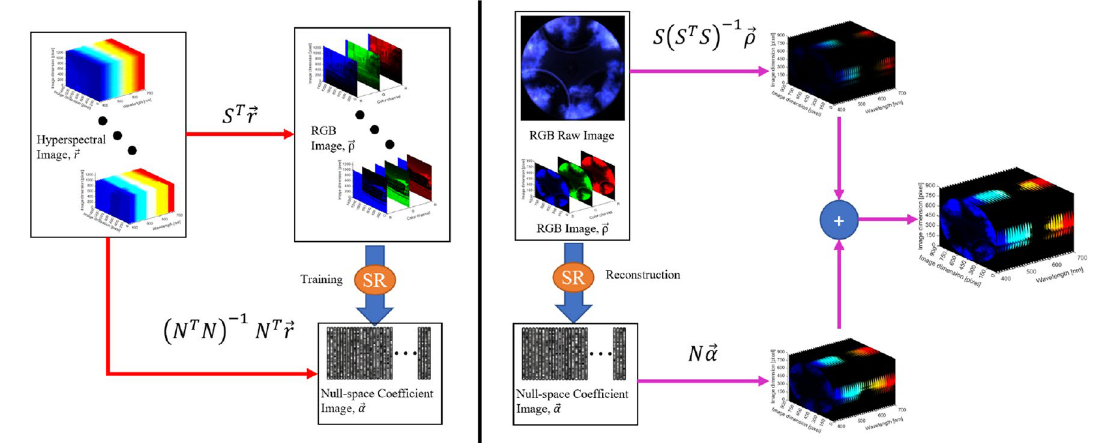
Figure 5. The training (left) and reconstruction scheme (right) of PPSR